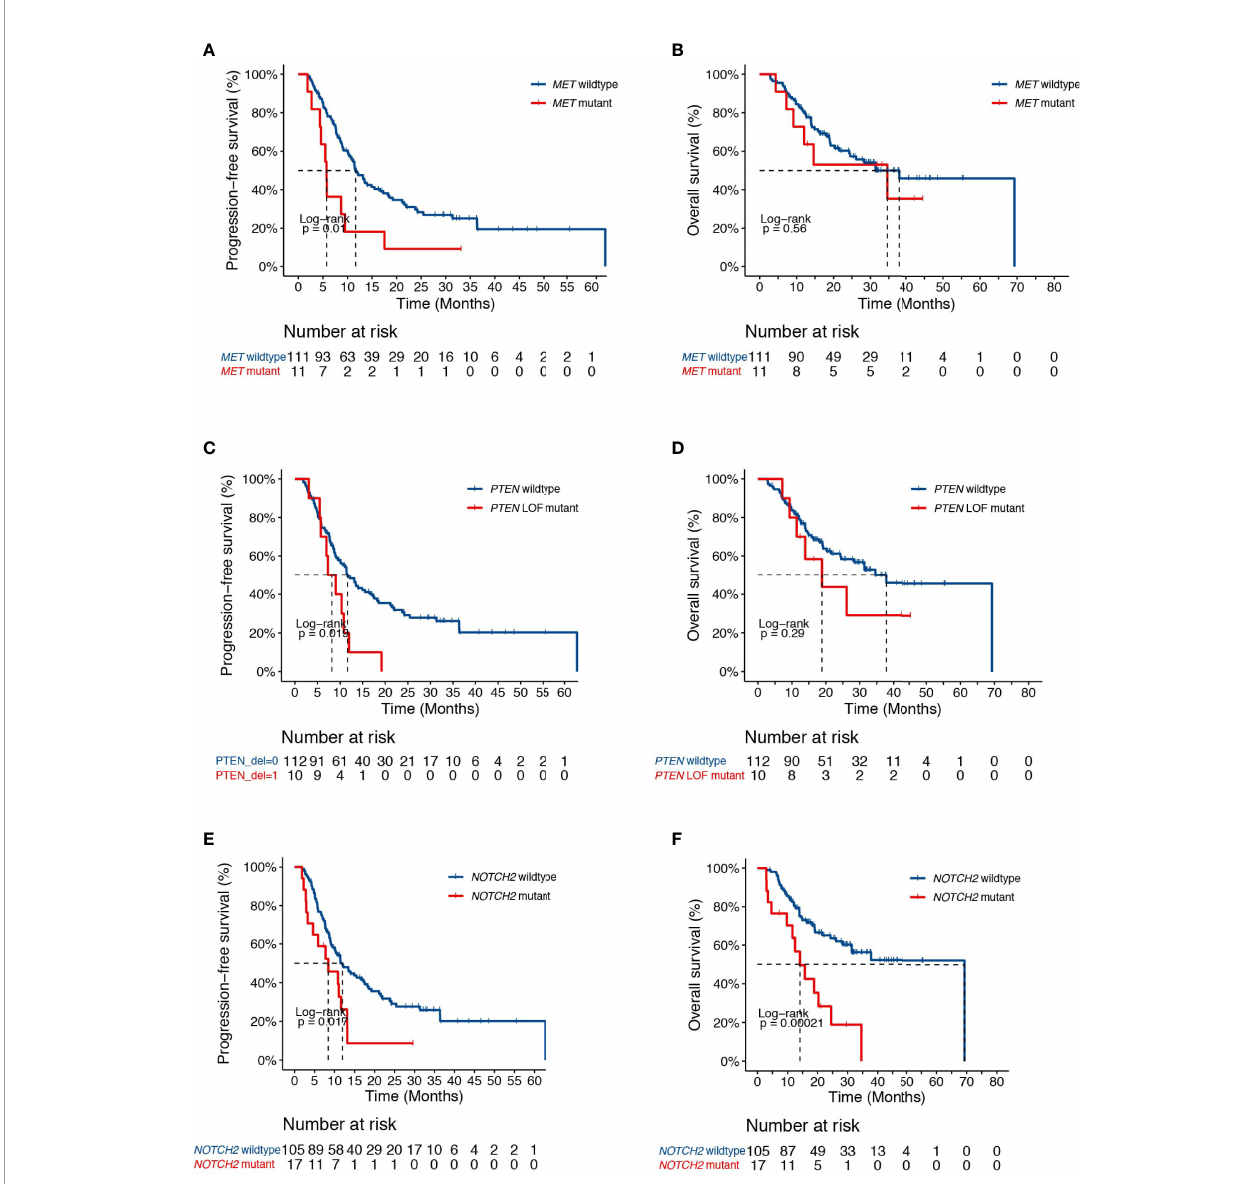
FIGURE 2 | Clinical associates of dCRT survival outcomes in NSCLC. (A, B) Kaplan-Meier estimates of (A) PFS and (B) OS in the full analysis set comparing patients with and without MET alterations. (C, D) Kaplan-Meier estimates of (C) PFS and (D) OS in the full analysis set comparing patients with and without PTEN deleterious mutations. (E, F) Kaplan-Meier estimates of (E) PFS or (F) OS in the full analysis set comparing patients with and without NOTCH2